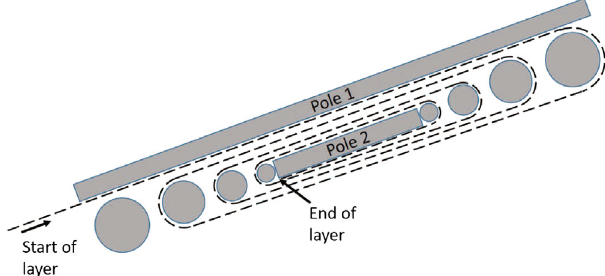
FIG. 4. Path of the conductor in an unwound bifilar helical structure.